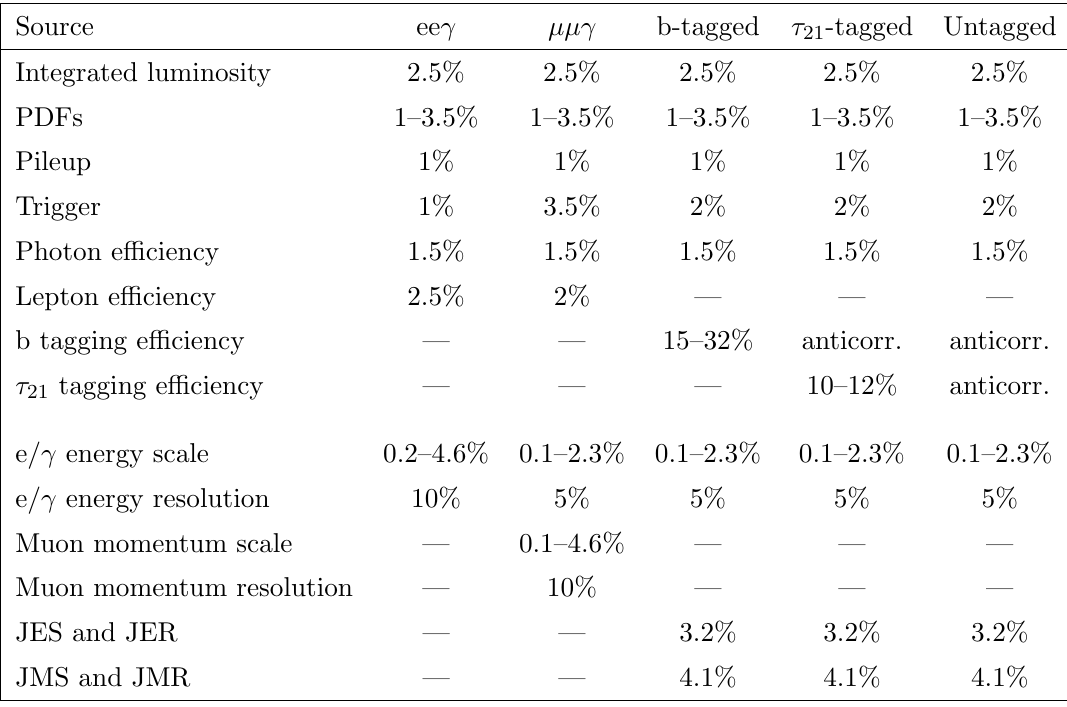
Table 1 . Summary of the systematic uncertainties in the signal yield (upper part of the table) or shape (lower part of the table). A dash indicates that the uncertainty does not